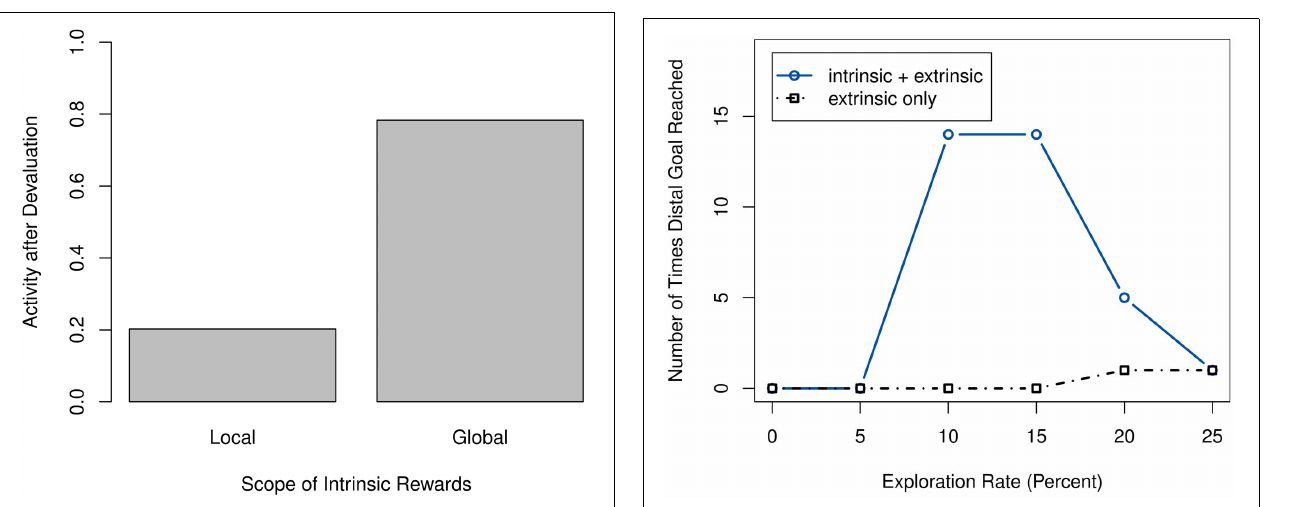
FIGURE 9 | Comparison of the number of times the agent reaches the distal goal after devaluation during 100 test episodes, with and without intrinsic rewards, for different exploration